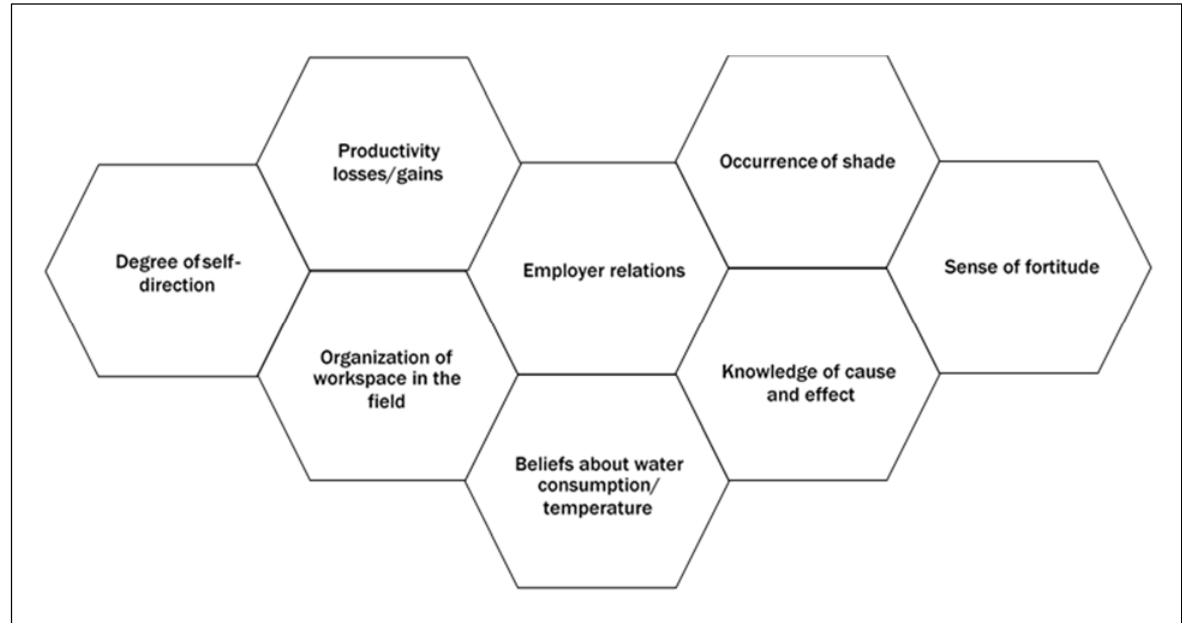
The honeycomb presentation helps to convey the associational relationships and complementarity of the eight factor clusters related to self-care. Each factor cluster can align with any other in a self-care decision. They are not grouped in any fixed position. Just as in a honeycomb structure, factor clusters are tightly connected together when shaping a self-care